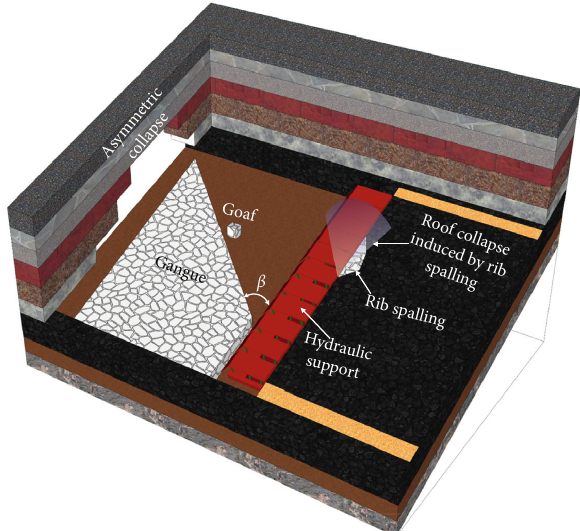
Figure 11: Filling characteristics of the mined-out area and in- stability forms of the surrounding rock in the working face.